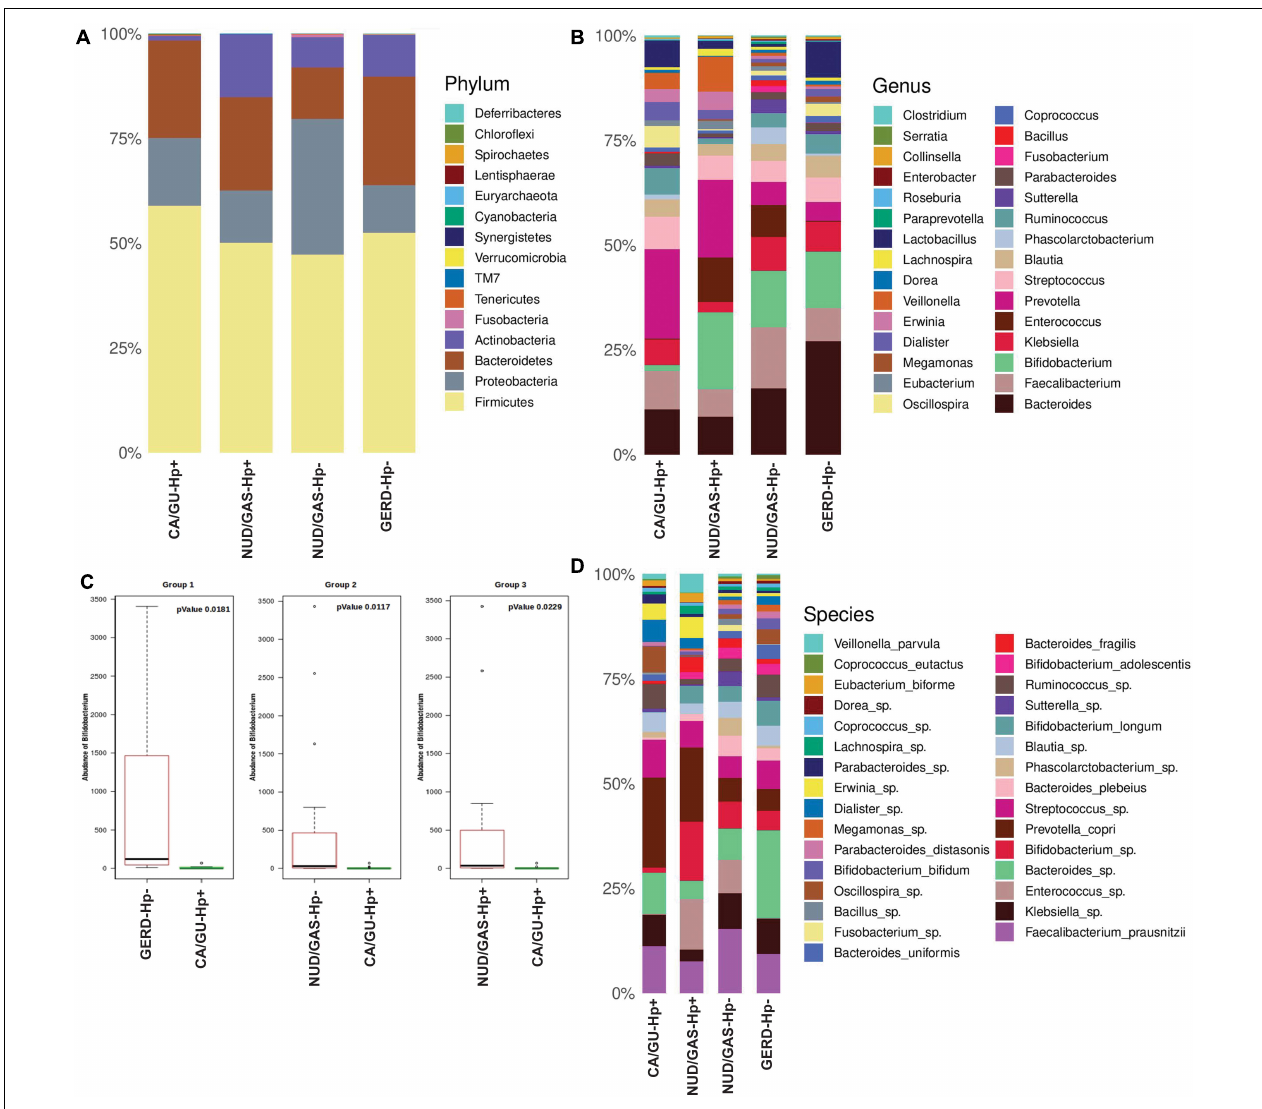
FIGURE 6 | (A) Relative abundances of different phyla in gut shown in stacked column for the CA/GU-Hp+, NUD/GAS-Hp+, NUD/GAS − Hp − , and GERD-Hp − groups. The CA/GU-Hp+ group have low relative abundance of Actinobacteria as compared to the other groups. (B) Relative abundances of different genera in gut shown in stacked column plot for the CA/GU-Hp+, NUD/GAS-Hp+, NUD/GAS- Hp − , and GERD-Hp − groups. Relative abundance of Bifidobacterium for the CA/GU-Hp+ group is significantly low. (C) Box plot analysis showing that the abundance of Bifidobacterium is significantly lower in the CA/GU-Hp+ group than the NUD/GAS-Hp+, NUD/GAS- Hp − , and GERD-Hp − groups. (D) Relative abundances of different bacterial species in gut shown in stacked column for the CA/GU-Hp+, NUD/GAS-Hp+, NUD/GAS- Hp − , and GERD-Hp − groups. Significantly low relative abundances of Bifidobacterium bifidum , Bifidobacterium adolescentis, and Bifidobacterium longum are identified for the CA/GU-Hp+